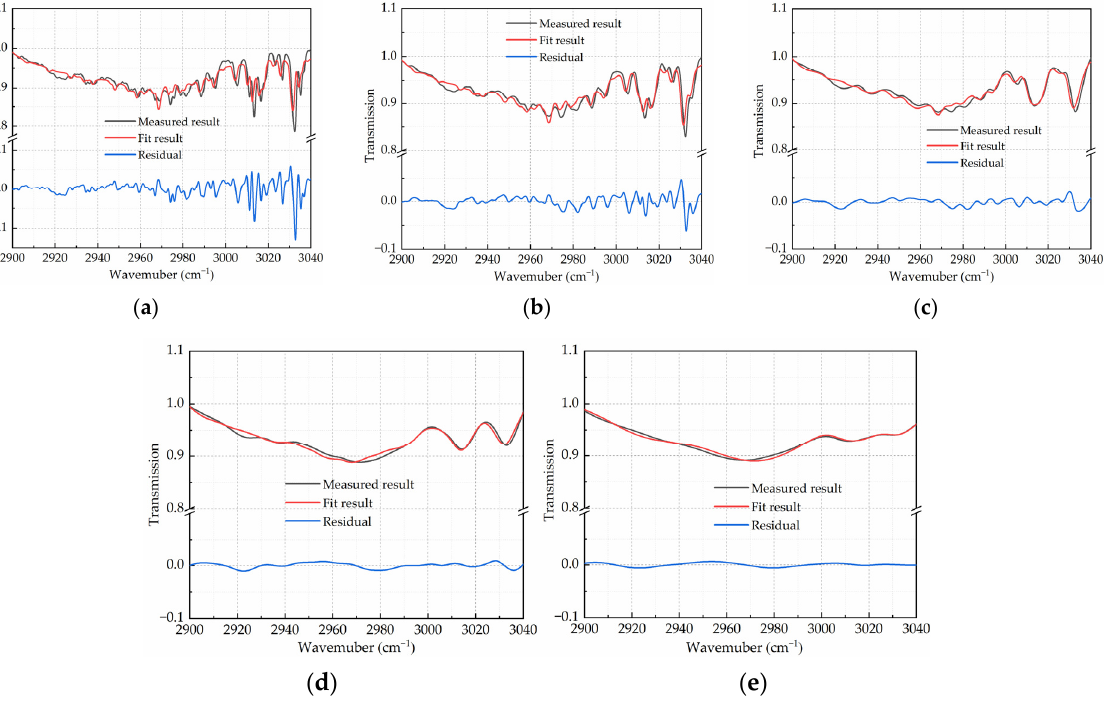
Figure 7. ( a ) the fitted C 3 H 8 spectral result and its residual at 1 cm − 1 ; ( b ) the fitted C 3 H 8 spectral result and its residual at 2 cm − 1 ; ( c ) the fitted C 3 H 8 spectral result and its residual at 4 cm − 1 ; ( d ) the fitted C 3 H 8 spectral result and its residual at 8 cm − 1 ; and ( e ) the fitted C 3 H 8 spectral result and its residual at 16 cm − 1 . Table 4. The SD of the fitting residuals of the C 2 H 4 and C 3 H 8 spectra at different resolutions.